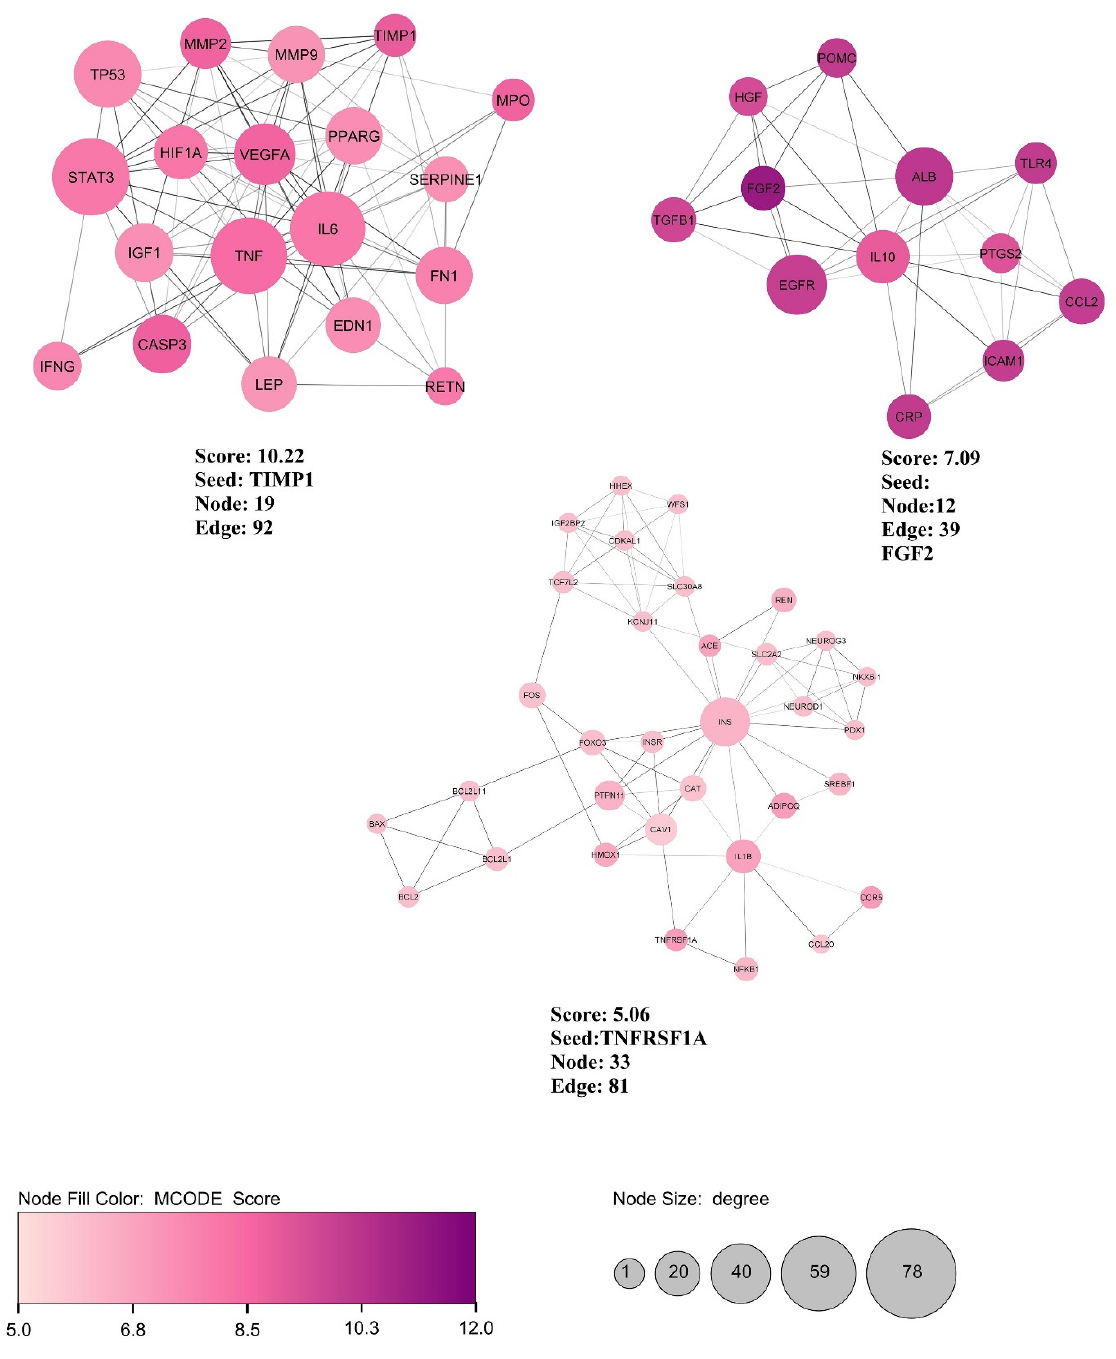
Figure 3. Three top clusters of the PPI network are constructed with important genes related to diabetes based on MCODE analyses. The specification of each MCODE containing MCODE1) Score: 10.22, Seed: TIMP1, Node: 19 Edge: 92. MCODE2) Score: 7.09, Seed: FGF2 Node: 12, Edge: 39. MCODE3) Score: 5.06, Seed: TNFRSF1A Node: 33, Edge: 81. The larger node size indicates a higher degree, and the higher intensity in node color indicates a higher MCODE score in the MCODE analysis.